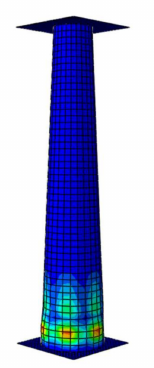
Figure 4. The form of buckling of the model with a thickness of 1–2